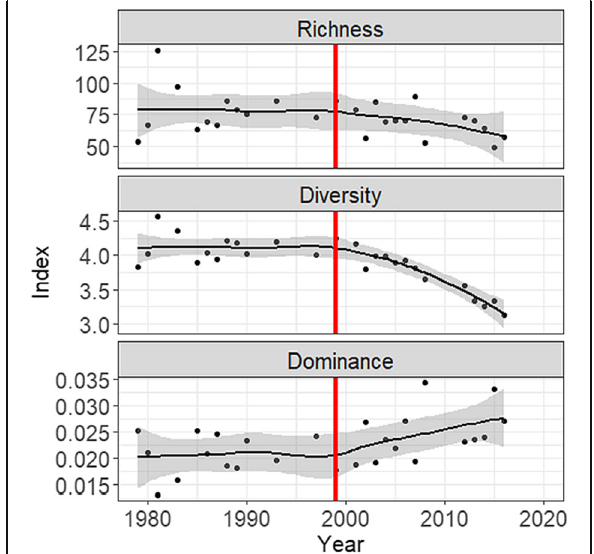
Fig. 10 Changes in species richness, diversity, and dominance showing the significant change points (red lines) cluster around the change point in species size frequency (Fig.